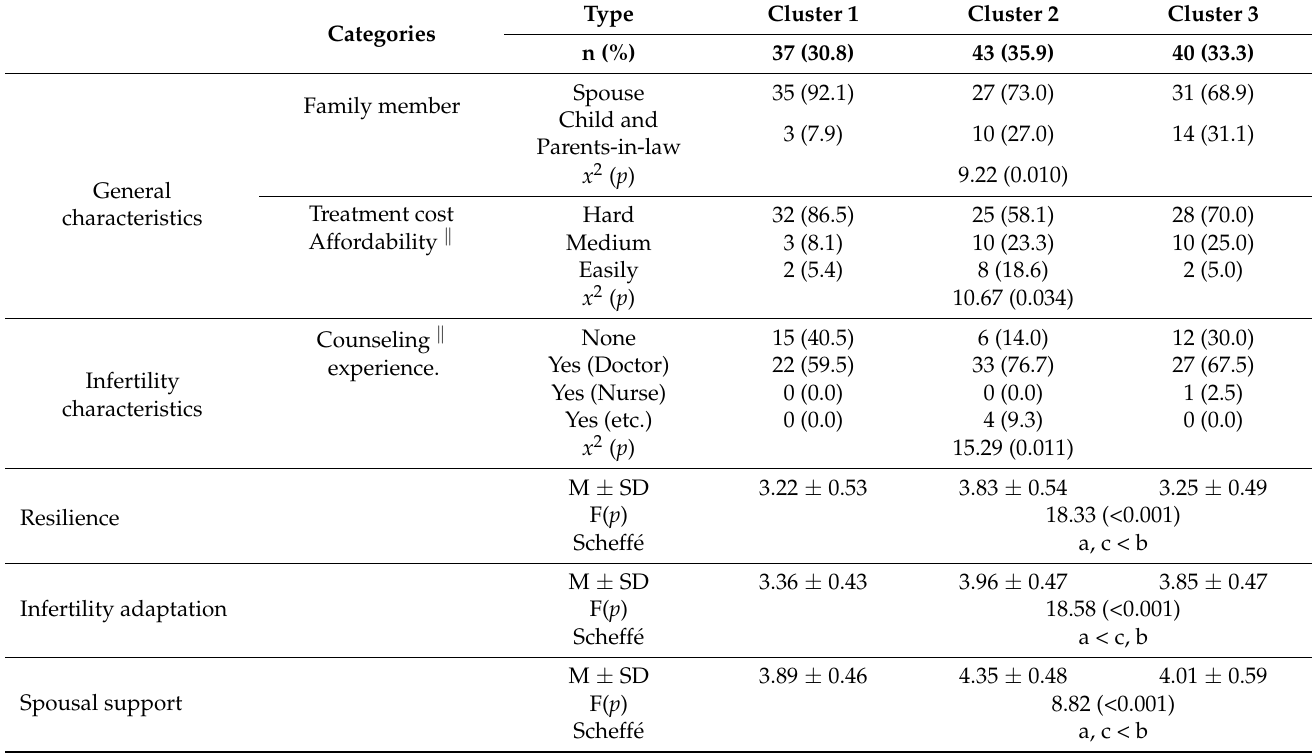
Table 4. Differences in variables according to the type of infertility stress coping ( N =